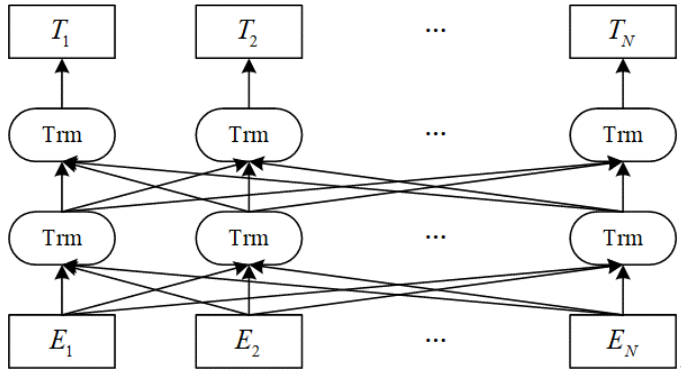
Figure 3. Structure of BERT.